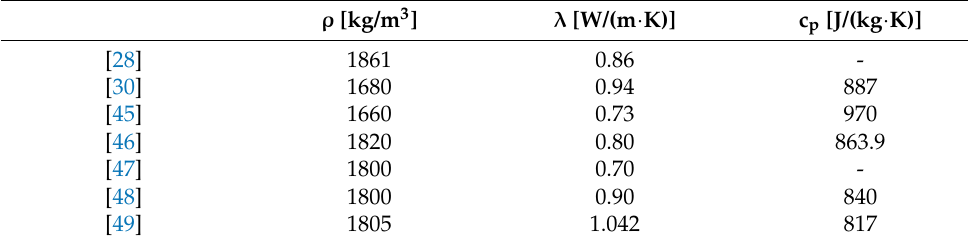
Table 4. Thermal properties of lime plasters found in